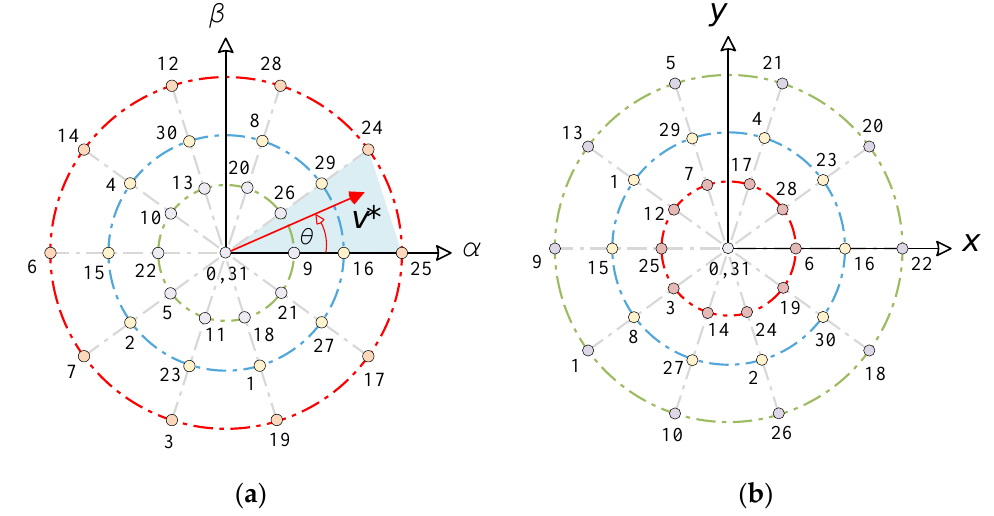
Figure 8. Space-vector model five-phase SSI. ( a ) 𝛼 − 𝛽 subspace. ( b ) 𝑥 − 𝑦 subspace.